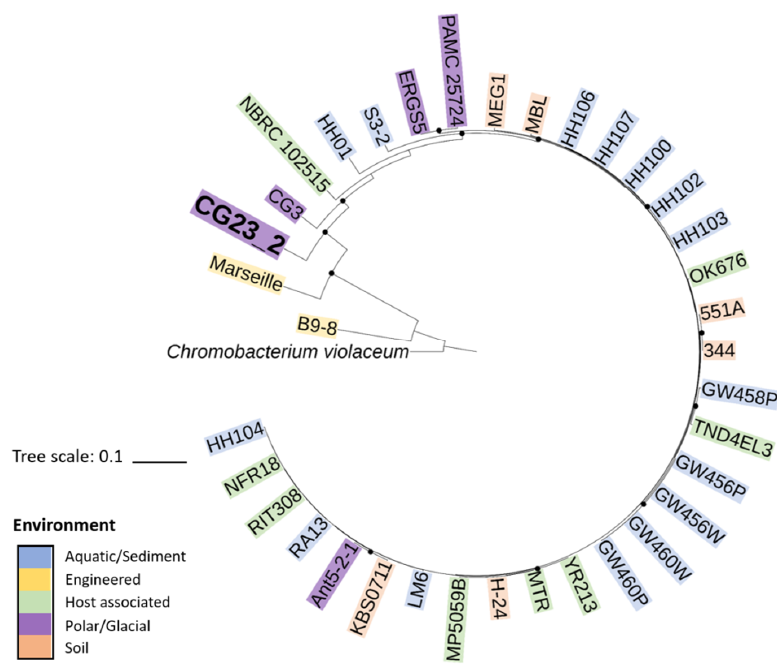
Figure 1. Maximum Likelihood tree of 36 Janthinobacterium spp. based on the Whelan And Goldman (WAG) + Freq. model. The tree is rooted to Chromobacterium violaceum (i.e., bacterium from closely related genera). The tree with the highest log likelihood ( − 37179.26) is shown. Circles indicate bootstrap values ≥0.9.